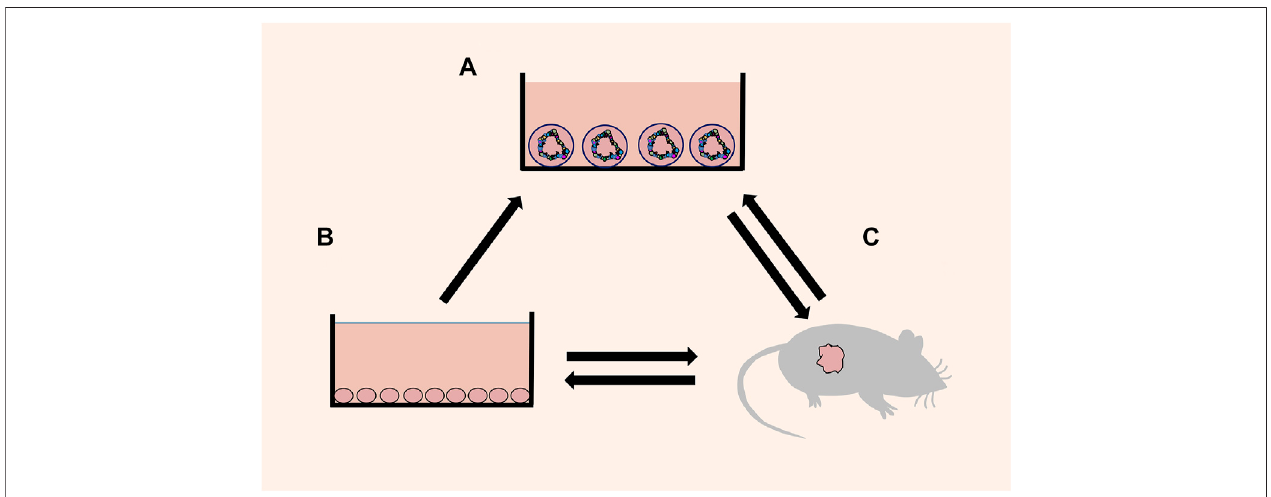
FIGURE 1 | Schematic diagram of mutual transformation. (A) Organoids: a 3D cell culture, which reproduces the cell composition, morphological structure and othercharacteristicsofthesourcetissue. (B) Celllines:a2Dcellcultureconsistingofasinglecell. (C) Xenografts:transplantationofhumantissue/cellsordirectlyinduced animal